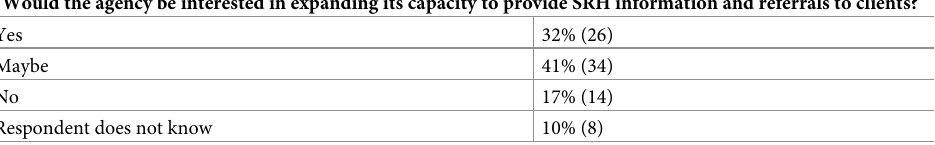
Table 3. Interest in expanding agency